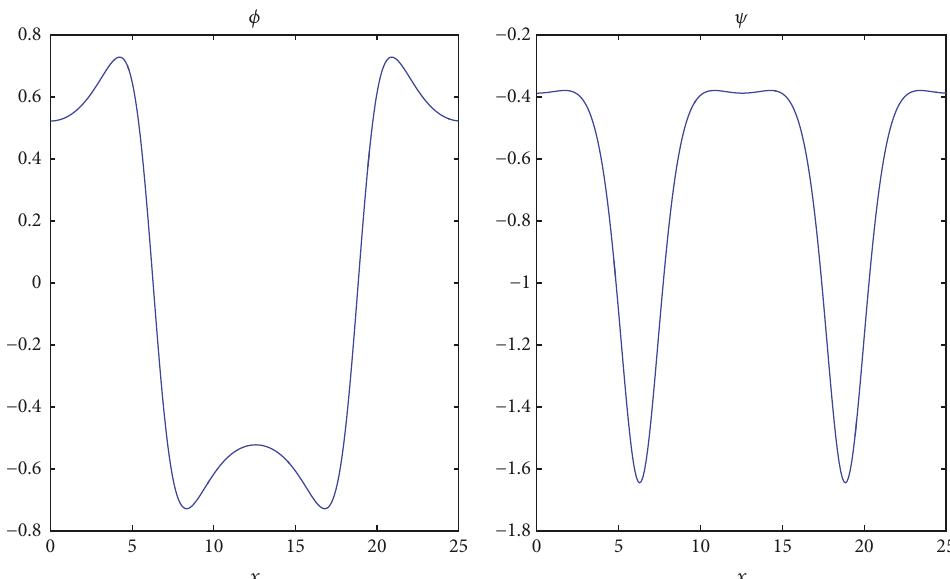
Figure 3: Approximations of the functions 𝜙, 𝜓 in the travelling wave solution (39) with 10 Newton’s iterations. The model’s parameters are 𝛼 = 𝛽 = 𝛾 = 1 , 𝑤 = 0.5 , and wave speed 𝑐 = 0.5 and the fundamental period is 𝐿 ≈ 25.13 .